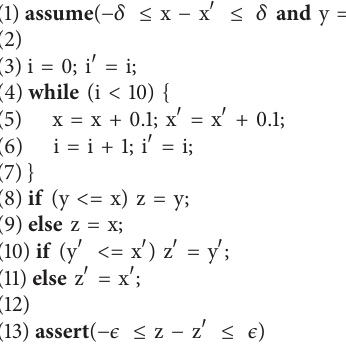
Figure5:Transformedself-compositionofthe min plus1 program for robustness